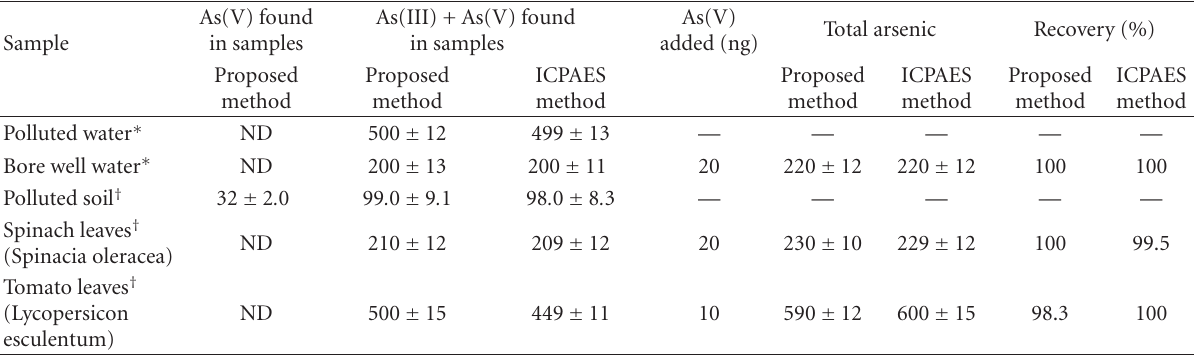
Table 5: Determination of arsenic in di ff erent environmental